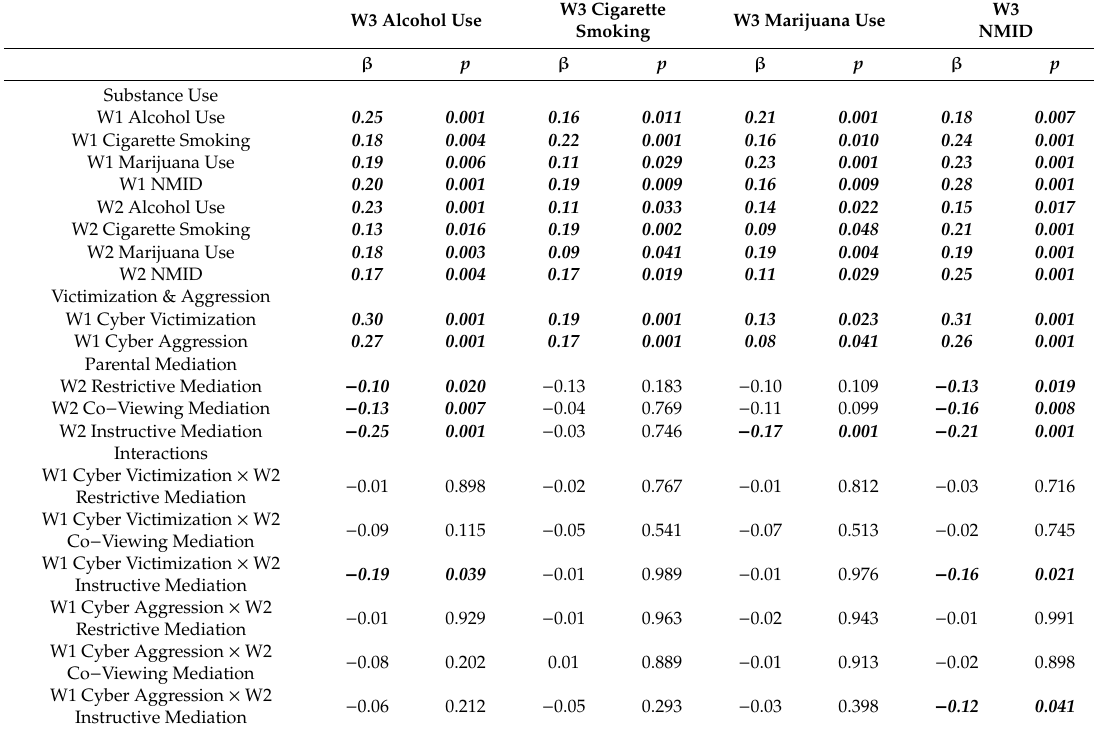
Table 3. Structural regression model results: Standardized regression coe ffi cients and significance